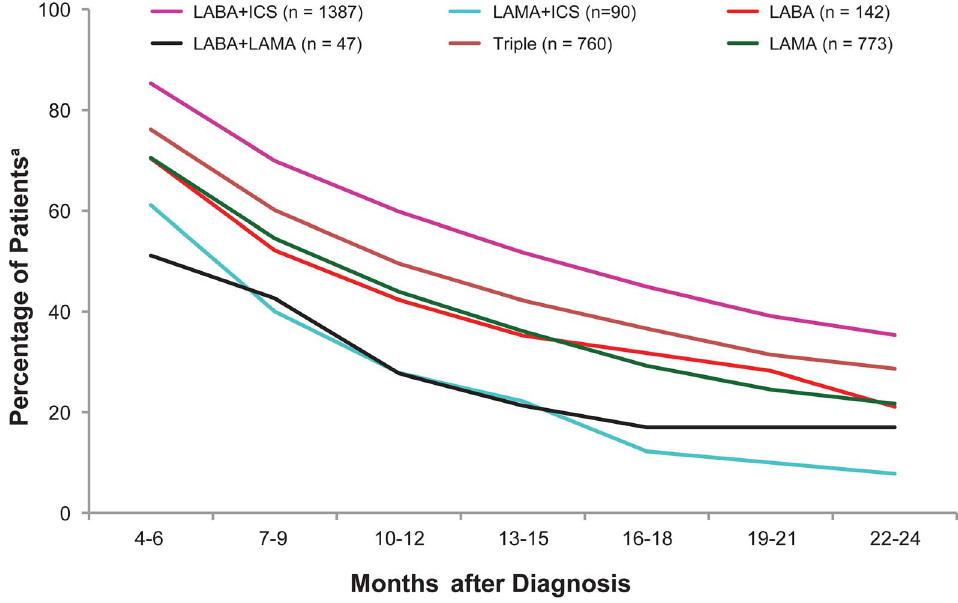
Figure 2. Proportions of patients continuing on the same treatment class for 24 months. a To be included in analysis, patients had to receive a prescription at each 3-month interval. Triple, LABA + LAMA + ICS. Abbreviations: ICS, inhaled corticosteroid; LABA, long-acting b 2 -agonist; LAMA, long-acting muscarinic antagonist.